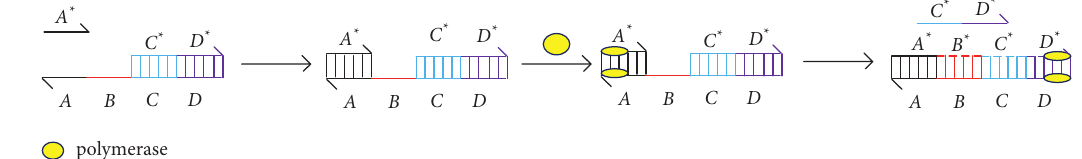
Figure 2: Principle of polymerase strand displacement reaction.